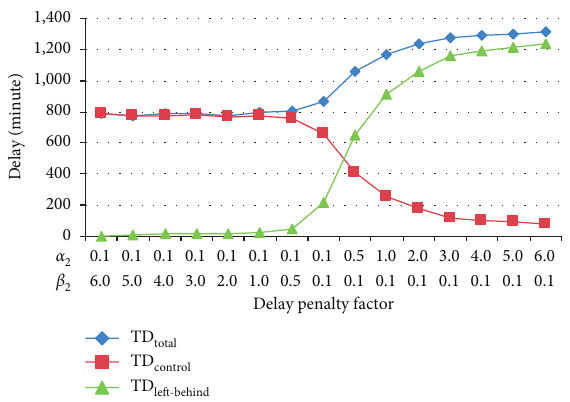
Figure 11: The results of Model II with different parameters.